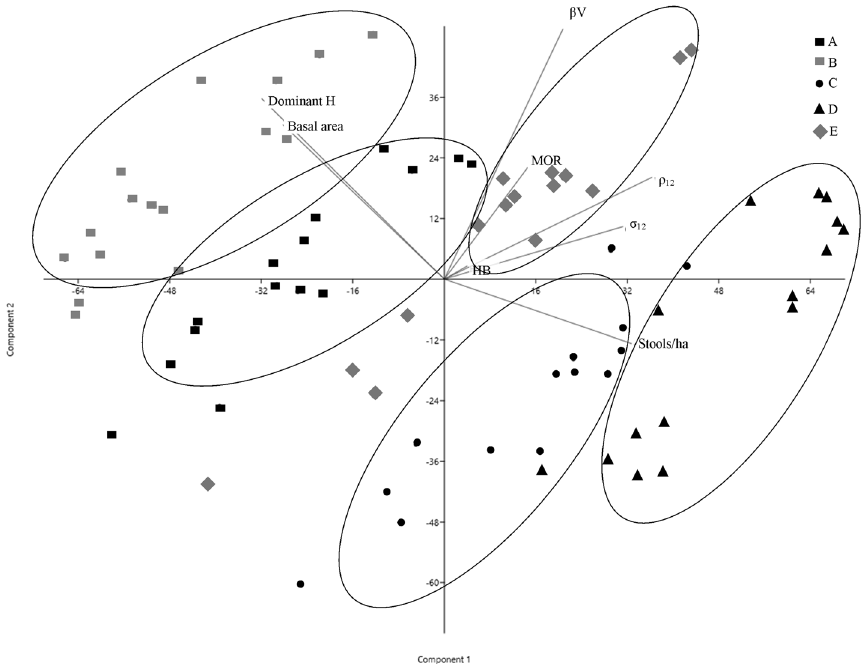
Figure 3. PCA of physical and mechanical wood properties, with principal dendrometric parameters of the five chestnut coppices on Amiata mountain. Wood density at 12% moisture (ρ12), total volumetric shrinkage (βV), compression strength (σ12), bending strength (MOR), Brinell hardness (HB), Individual shoots basal area (Basal area), stools per hectar mean value (Stools/ha), Shoots top height mean value per stand (Dominant